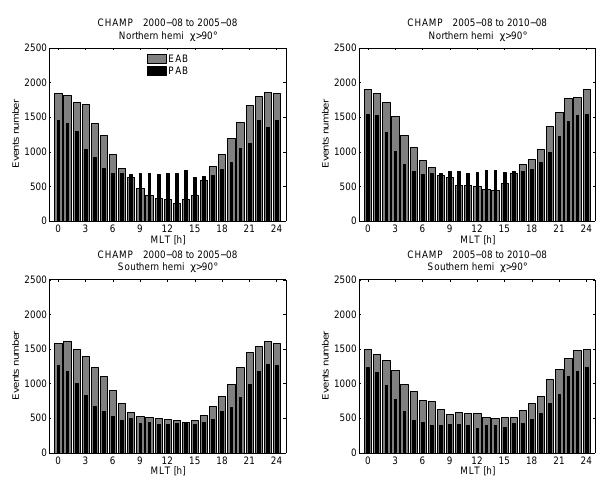
Figure 3. The magnetic local time distribution of the auroral bound- Fig.3. Themagneticlocaltimedistributionoftheauroralboundarydetectionsduringhigh(left)andlow(right) ary detections during high (left) and low (right) solar activity years solar activity years separately for both hemispheres. separately for both hemispheres.